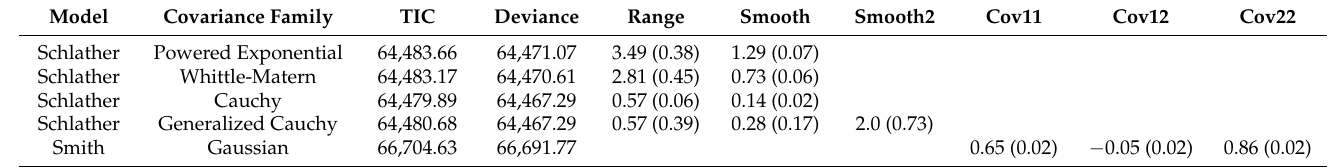
Table 5. Max-stable process fitted to the third cluster of the average annual precipitation.